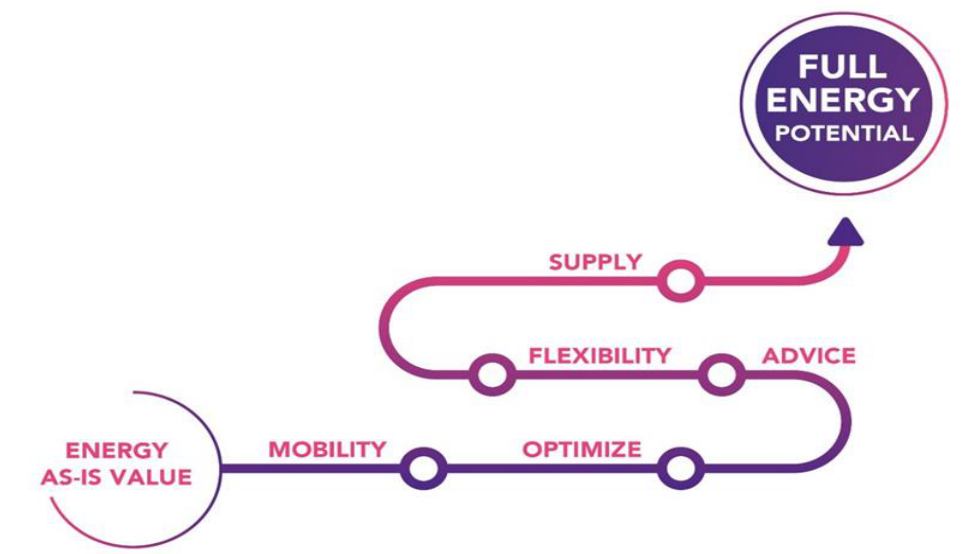
Figure 6: Customized